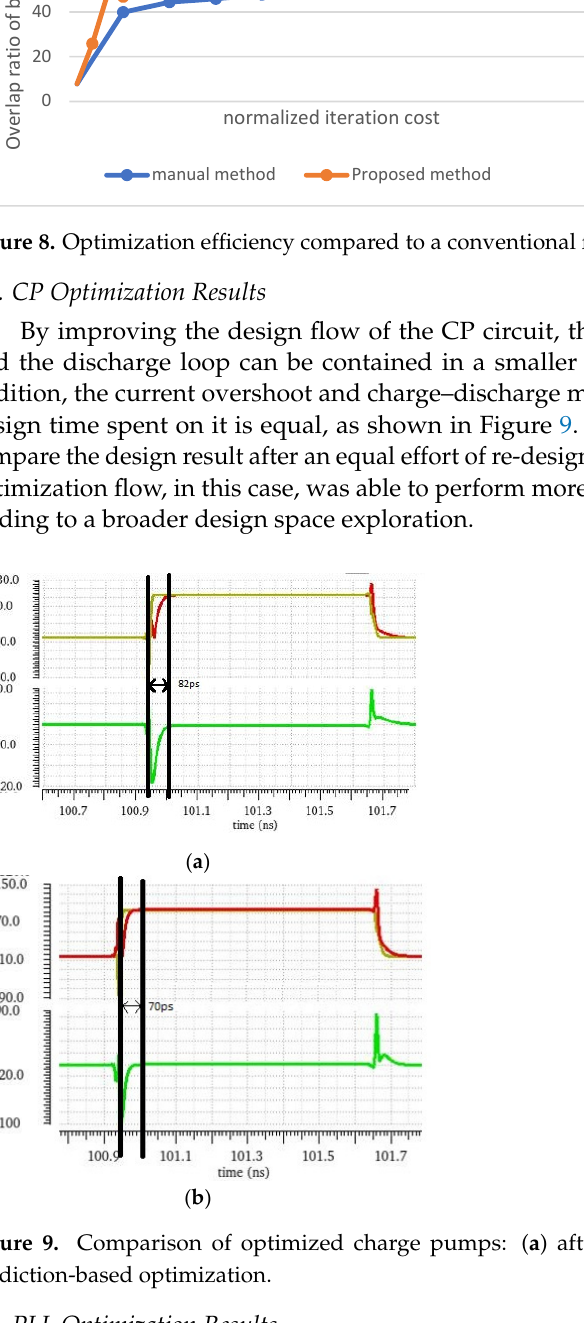
Figure 10. Optimization result compared to a conventional flow on overall PLL: ( a ) manual optimi- zation with limited iterations; ( b ) proposed optimization with more layout-free design iterations.